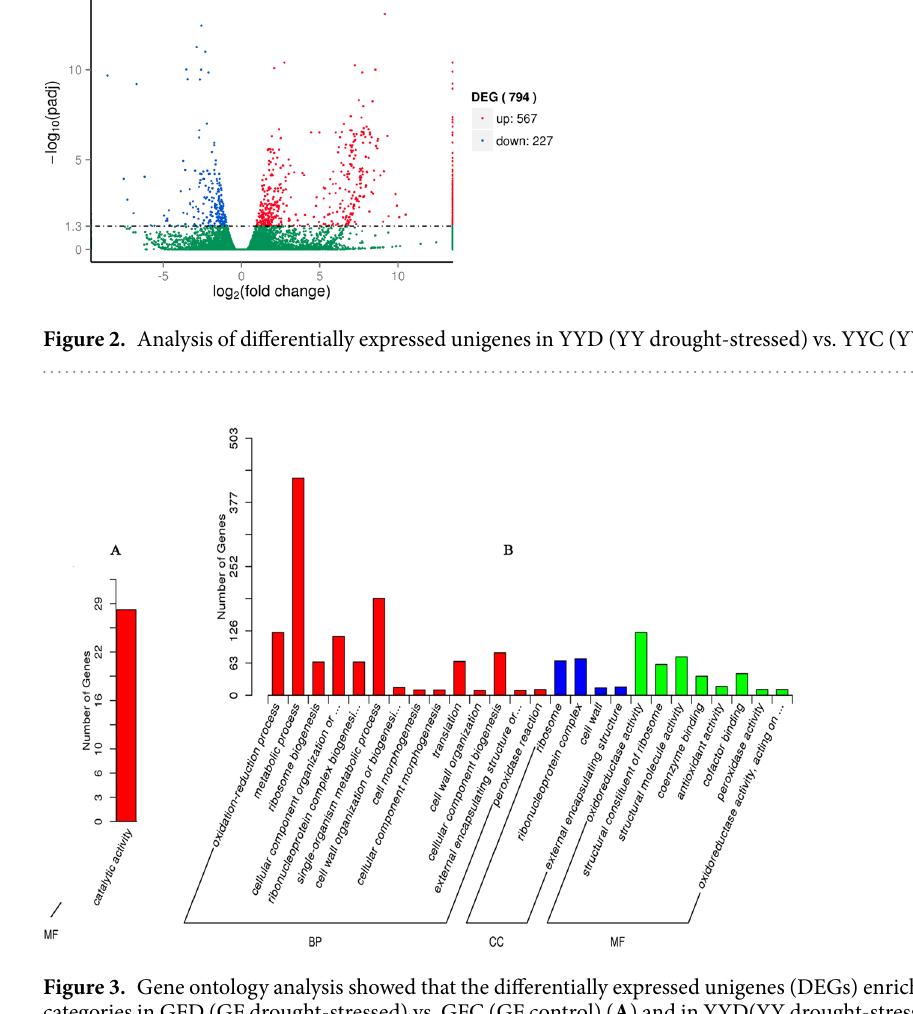
Figure 3. Gene ontology analysis showed that the differentially expressed unigenes (DEGs) enrichment categories in GFD (GF drought-stressed) vs. GFC (GF control) ( A ) and in YYD(YY drought-stressed) vs. YYC (YY control) for biological process (BP) ( B ), cellular component (CC) ( B ), and molecular function (MF) ( B